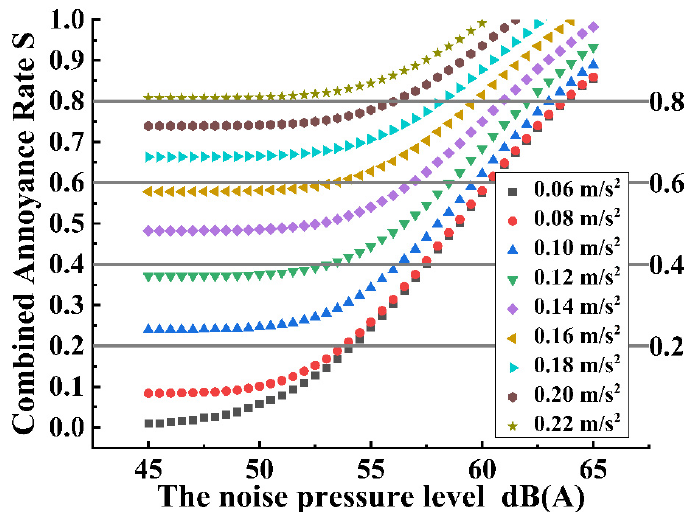
Figure 5. The influence of noise level on the assessment of vibration.